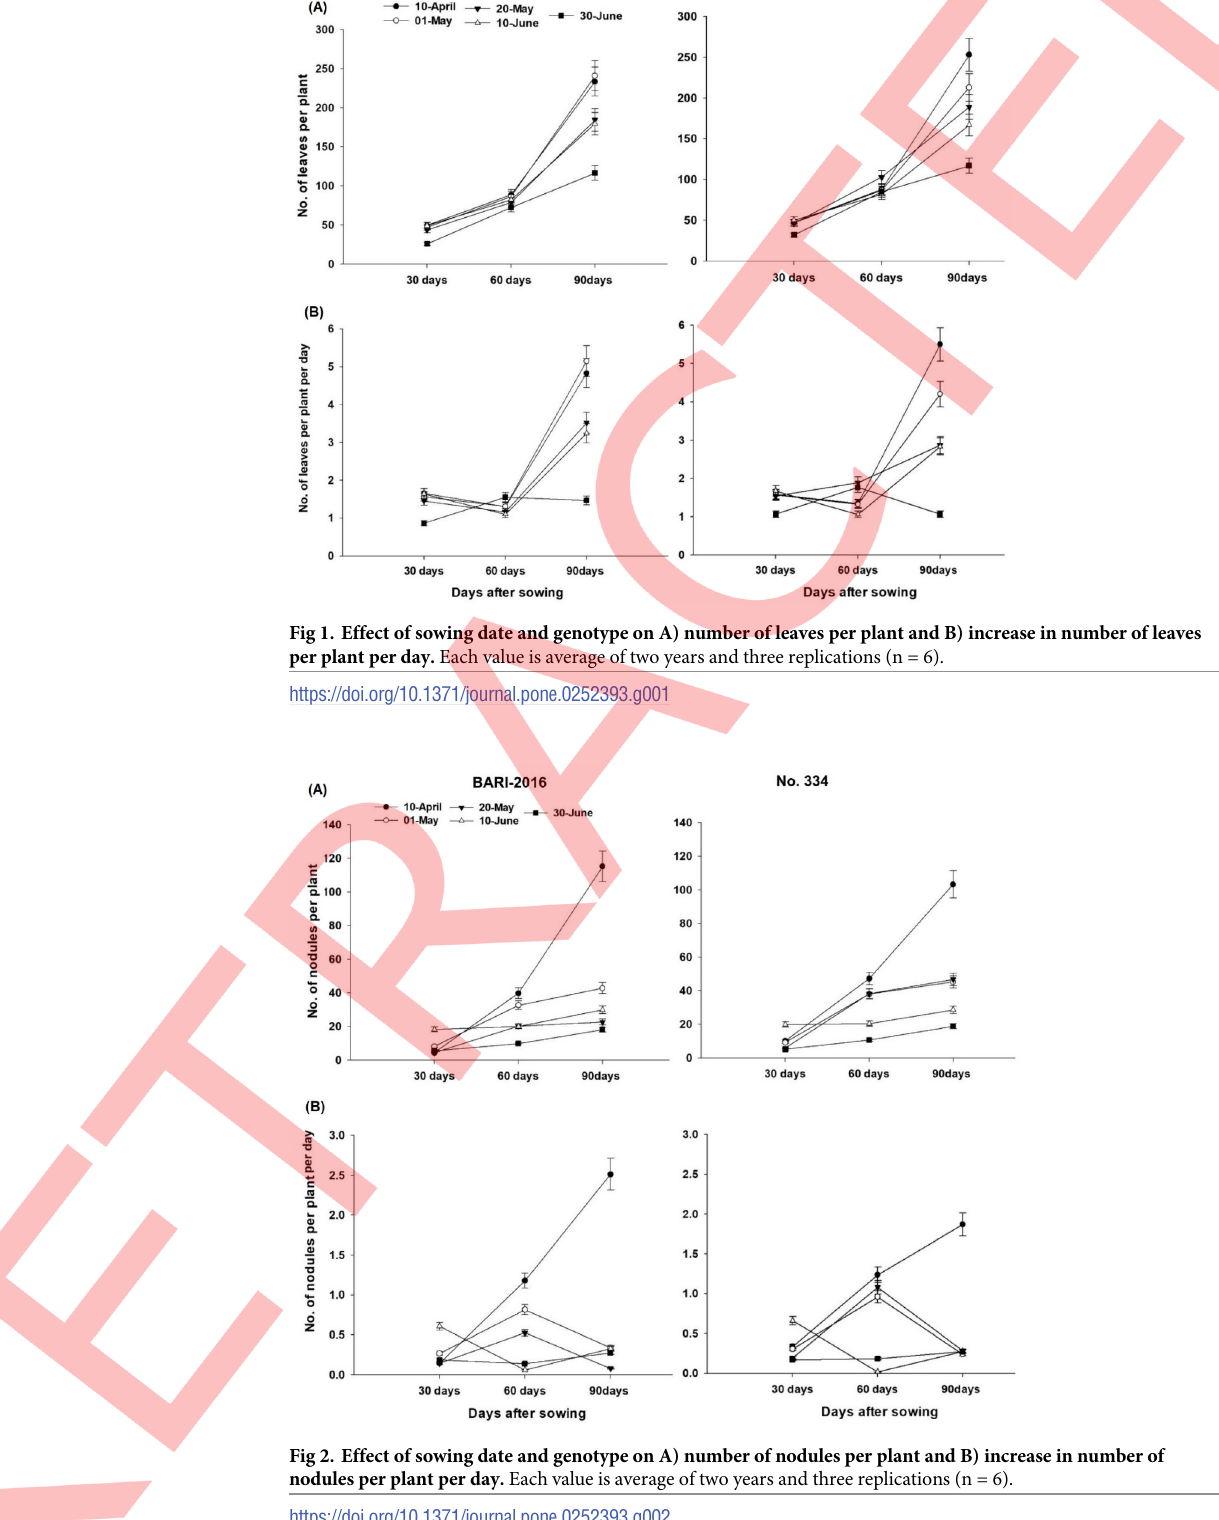
PLOS ONE | https://doi.org/10.1371/journal.pone.0252393 June 10,